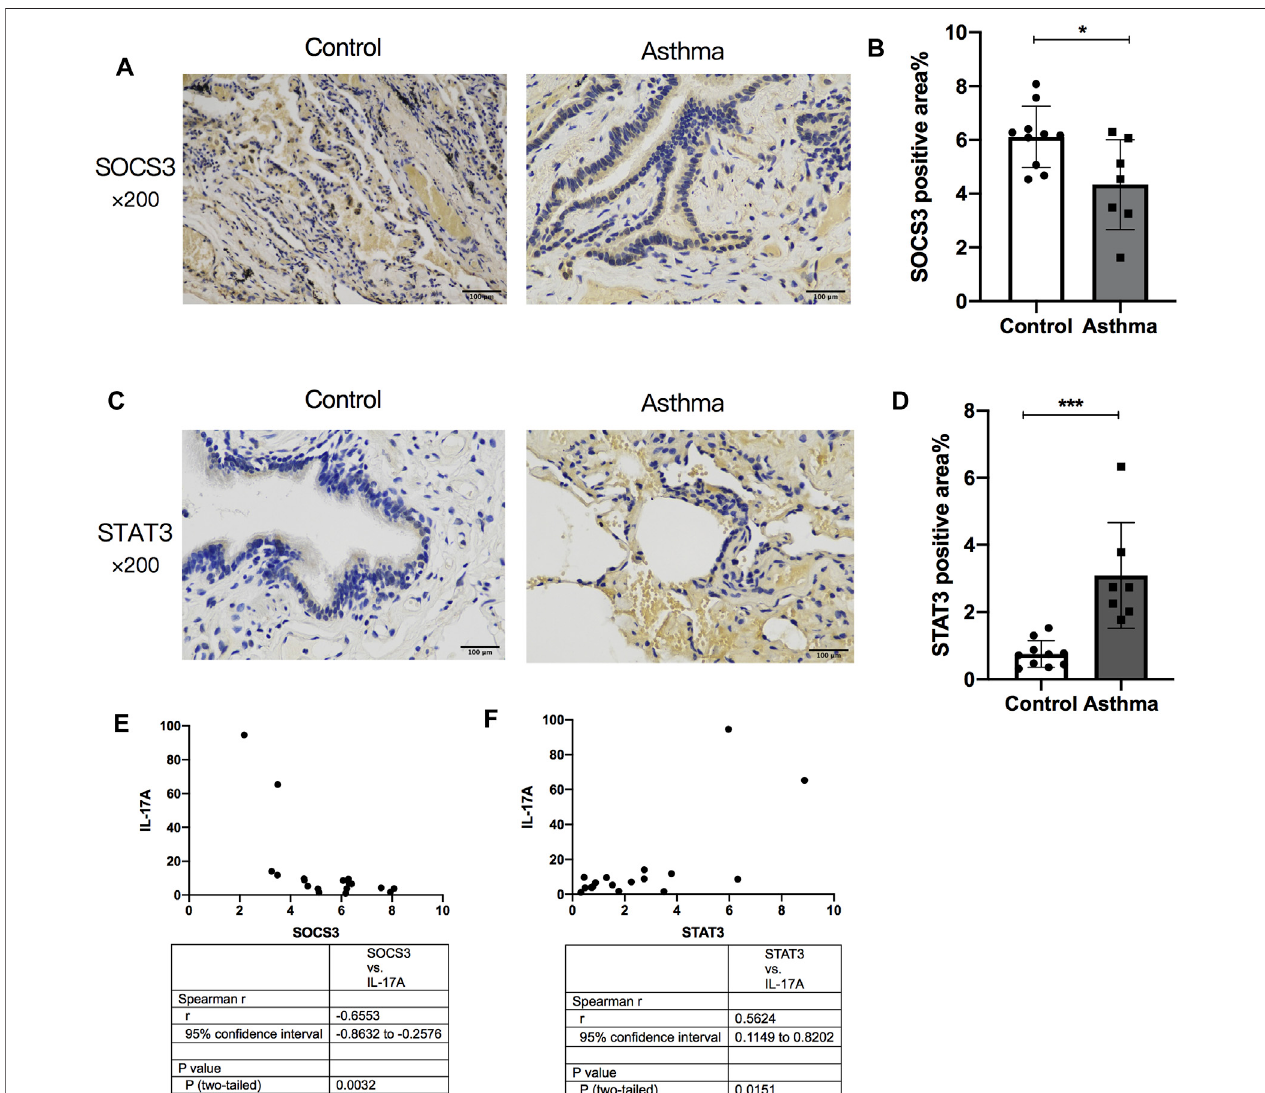
FIGURE7| ComparisonofSOCS3expressionandSTAT3expressioninnormallungtissuebetweenasthmapatientsandhealthycontrolsandtheircorrelationwith IL-17A expression in the lung. The expression of STAT3 and SOCS3 in lung tissues of 17 patients undergoing thoracotomy for pulmonary nodules was analyzed by immunohistochemistry. (A) Representative photomicrographs of immunohistochemistry of SOCS3 in lung-tissue slices of the asthma group and control group. (B) Percent SOCS3-positive area around airways. (C) Representative photomicrographs of immunohistochemistry of STAT3 in lung-tissue slices of asthma and control groups. (D) Percent STAT3-positive area around airways. (E) Correlation between the percent STAT3-positive area and the expression of IL-17A protein in humanlungtissue. (F) CorrelationbetweenthepercentSOCS3-positiveareaandtheexpressionofIL-17Aproteininhumanlungtissue.SOCS3,suppressorofcytokine signaling 3; STAT3, signal transducer and activator of transcription 3. * p < 0.05; ** p < 0.01; *** p < 0.001. Scale bar (cid:1) 100 μ m.